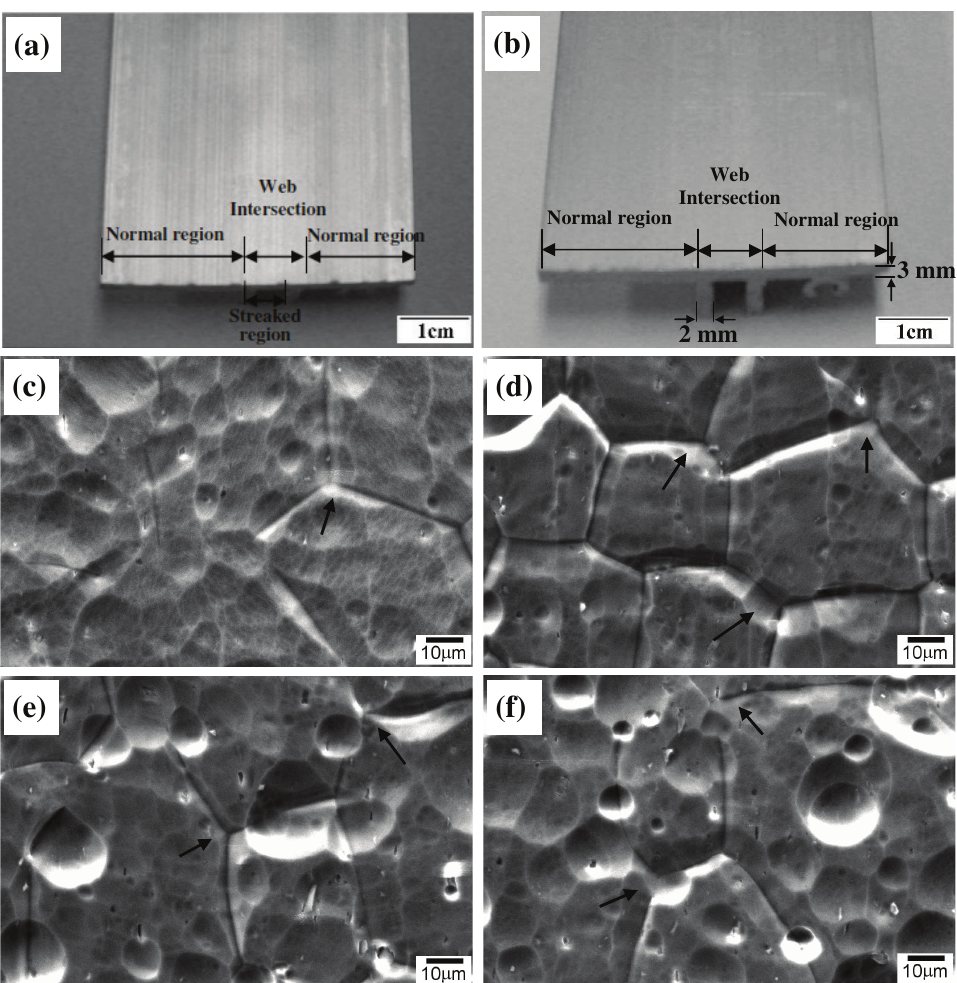
Figure 1. Profiles of anodized aluminium extrusions with (a) 0.17 wt.% Fe and (b) 0.29 wt.% Fe, and SEM morphology of anodized low-iron extrusion in (c) web intersection region and (d) normal region, and high-iron extrusion in (e) web intersection region and (f) normal region [10]. Arrows indicate grain boundary